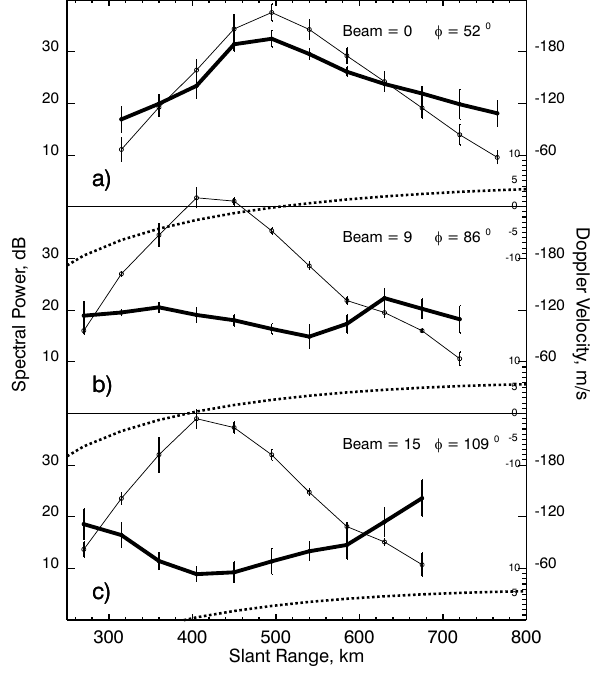
Fig. 2. Slant range profiles of echo power (thin solid line), Doppler velocity (thick solid line), and aspect angle (dotted line), for CUT- LASS beams 0, 9, and 15 for 31 March 2000, 14:40–14:50 UT. Scale for aspect angle is indicated on the right vertical axis by small ticks with zero aspect corresponding to horizontal lines at the bottom of each panel. The averaged for slant ranges 270–765km L -shell angle φ for each beam is shown in the right top corner of each